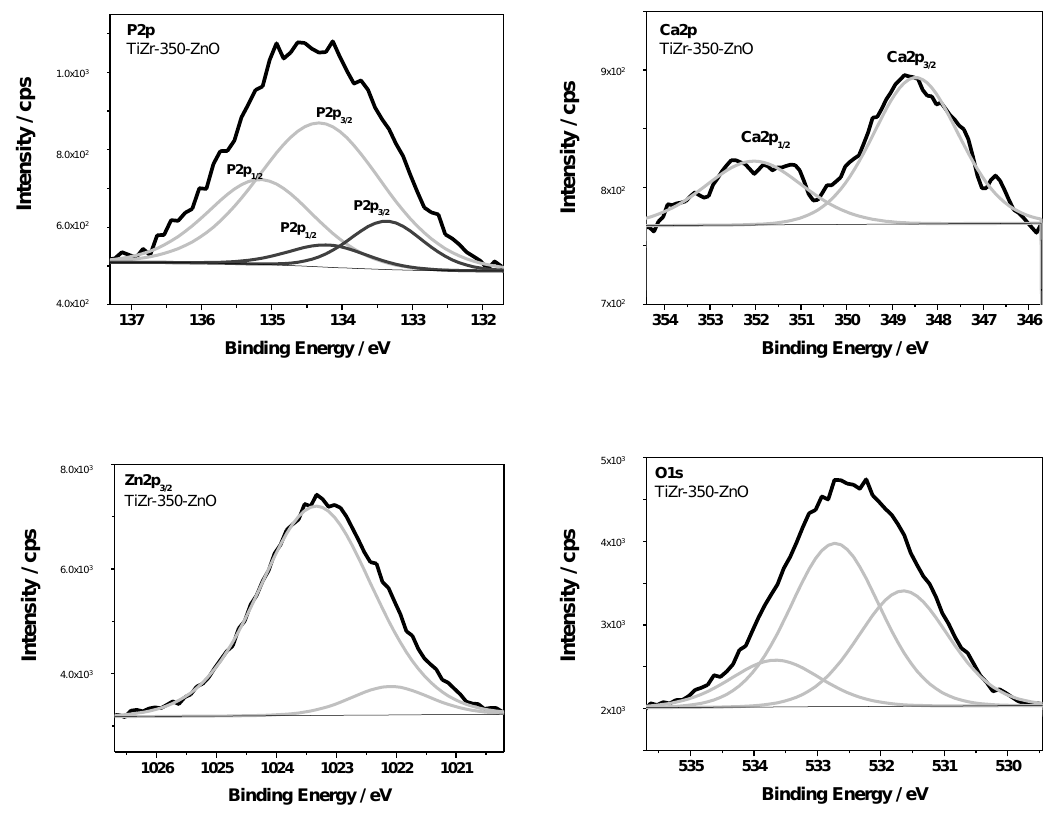
Figure 6. The high resolution XPS spectra after the deconvolution procedure, sample TiZr-350-ZnO. Normalized photoluminescence (PL) spectra of ZnO-incorporated oxide coatings are shown in Figure 7. PEO treated samples without ZnO incorportion showed broad asymmetric peak, centered at 524 nm. The observed peak corresponded to TiO 2 emission [33]. The observed emission was related to oxygen vacancies and self-trapped excitons [34]. After the PEO process with ZnO nanoparticles the emission spectra changed. Red shift of emission peak from 524 to 530–536 nm was observed. New